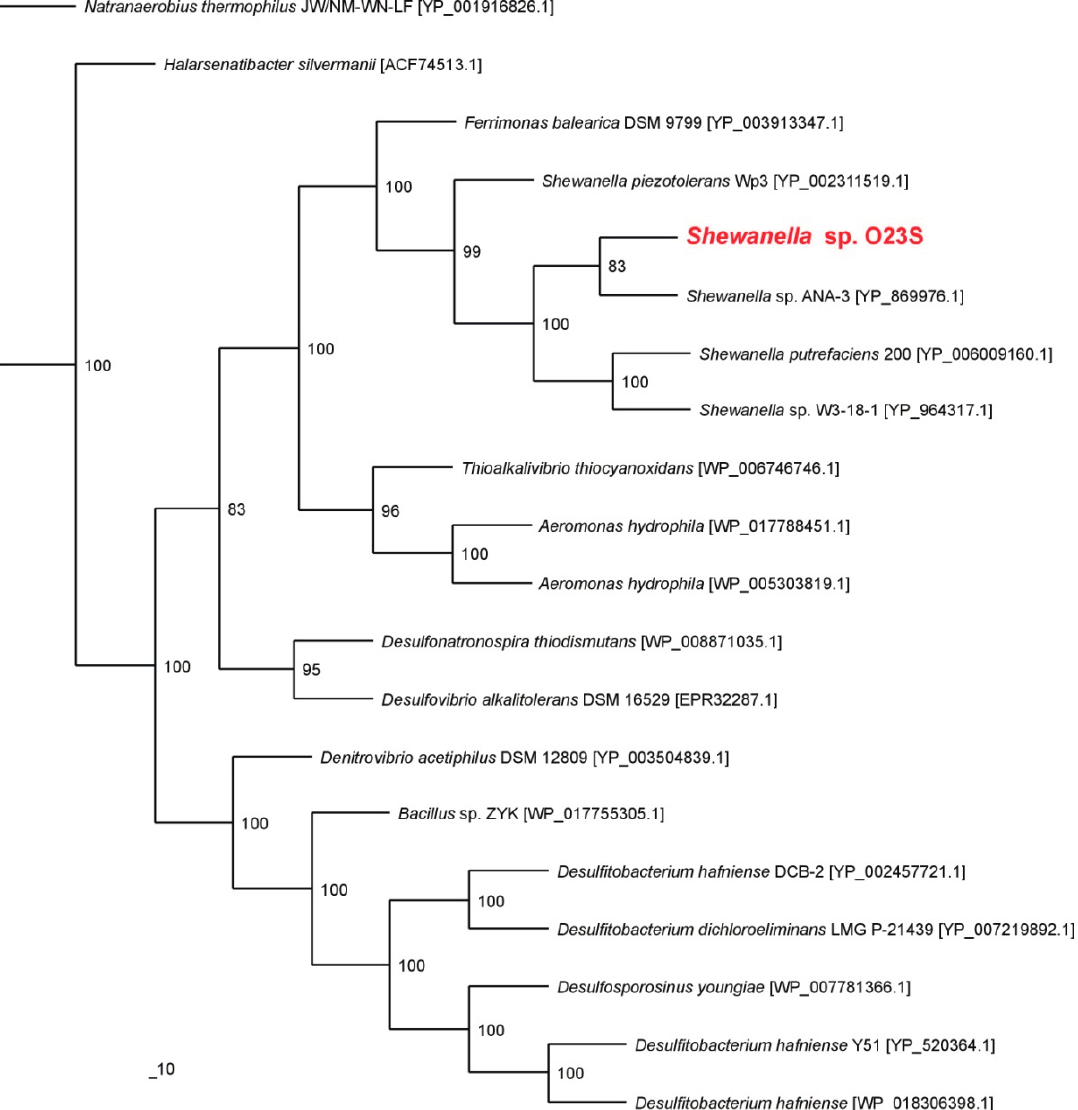
Figure 1. Phylogenetic tree of the dissimilatory arsenate reductase ArrA based on 20 sequences. The investigated strain is indicated in red. The unrooted tree was constructed using the Maximum Likelihood algorithm according to Jones-Taylor-Thornton (JTT)